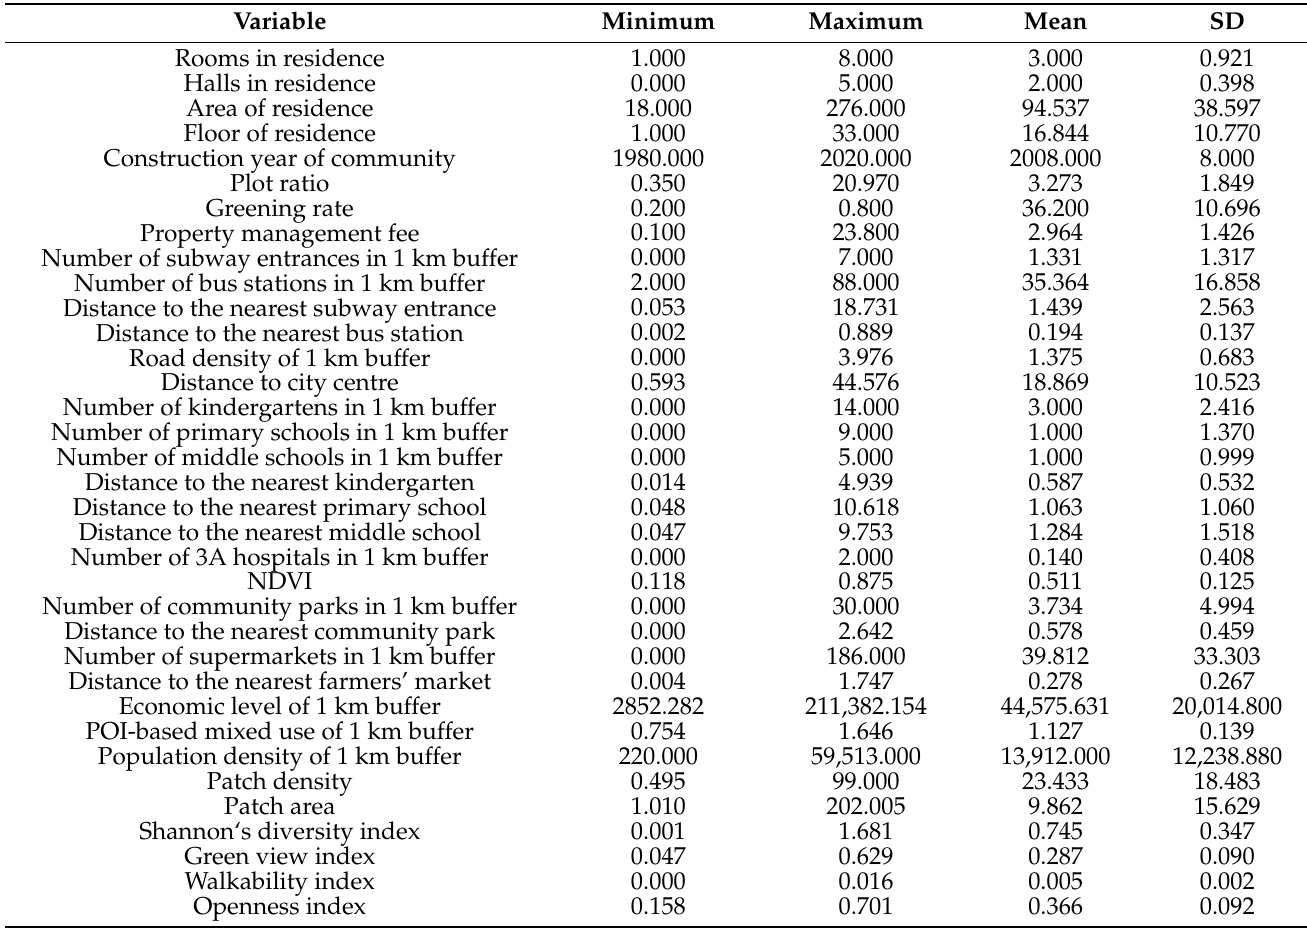
Table 1. Descriptive statistics of the influential factors of housing